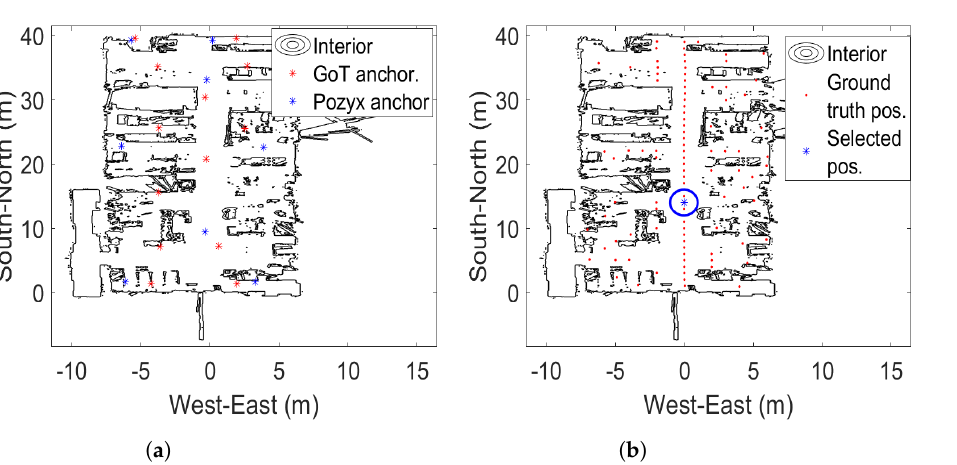
Figure 2. ( a ) Laboratory outline (ROSmap). Placement of Pozyx (blue) and GoT (red) anchors. ( b ) Placement of 100 ground-truth reference points (red). Ground truth point selected for detailed analysis (in blue